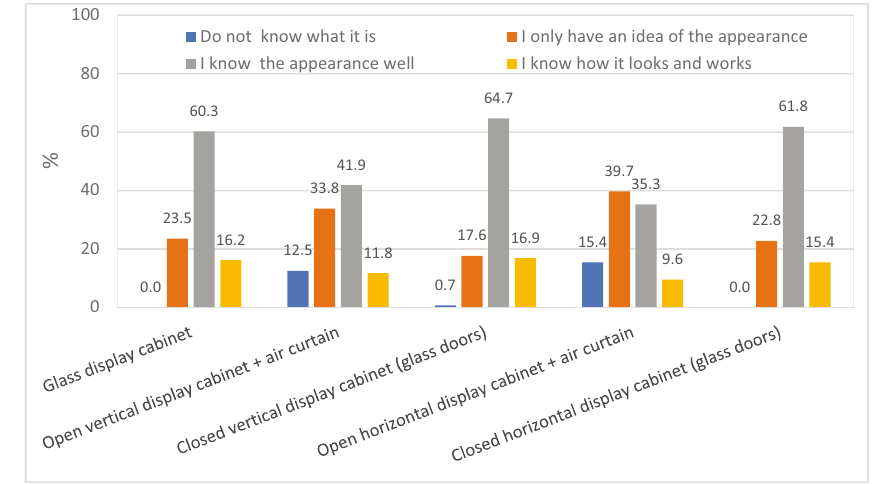
Figure 3: Results for the question: “ Indicate your level of knowledge about each type of RDC ”